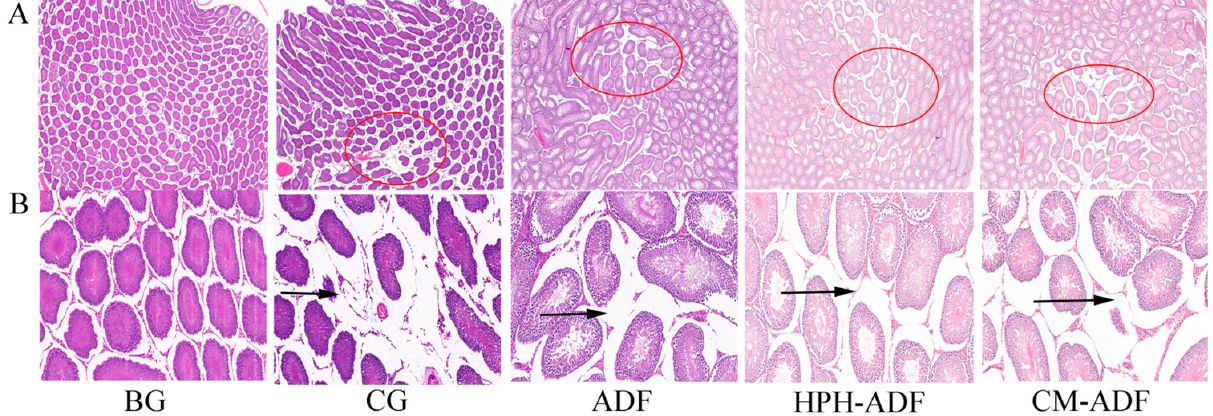
Figure 6. Hematoxylin-eosin-stained section of rat testis. ( A ) 2 × magnification; ( B ) 20 × magnification. From left to right: blank group (BG) showing normal appearance, control group (CG), ADF group, HPH-ADF group and CM-ADF group. Red circles indicate tissue edema; black arrows indicate significantly increased and decreased volume ratio of seminiferous tubules.